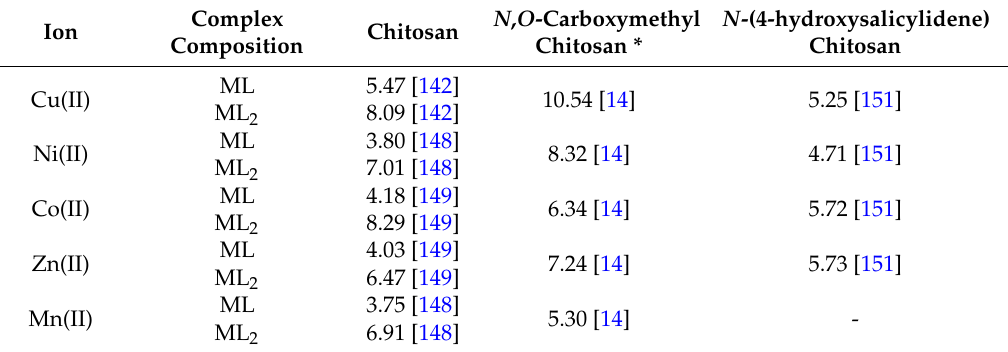
Table 6. Stability constants for complexes of transition metals with chitosan and its derivatives at the metal:ligand ratios 1:1 (ML) and 1:2 (ML 2